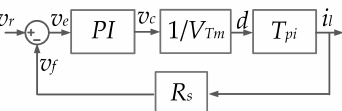
Figure 7. Block diagram representation of the ACMC’s closed-loop control with a PI controller.